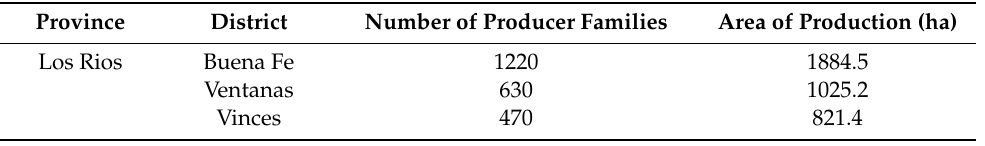
Table 2. Number of producers and cocoa production